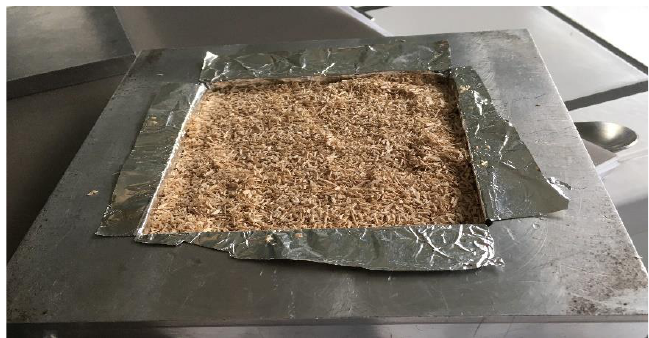
Figure 2. Stainless steel mold with ready-to-press mixture.